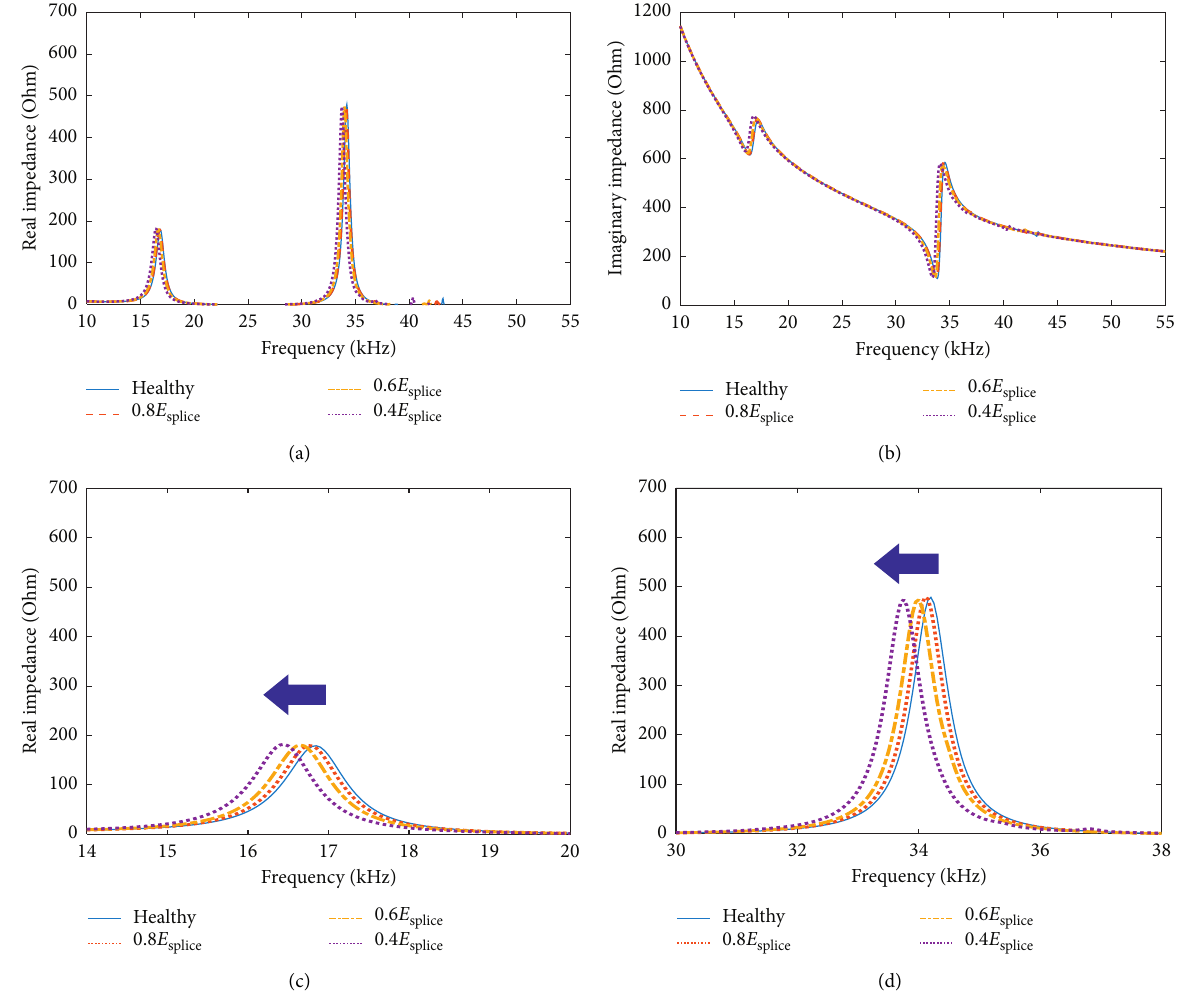
Figure 30: Numerical EMI signatures under structural damage. (a) Real part. (b) Imaginary part. (c) Peak 1. (d) Peak 2.